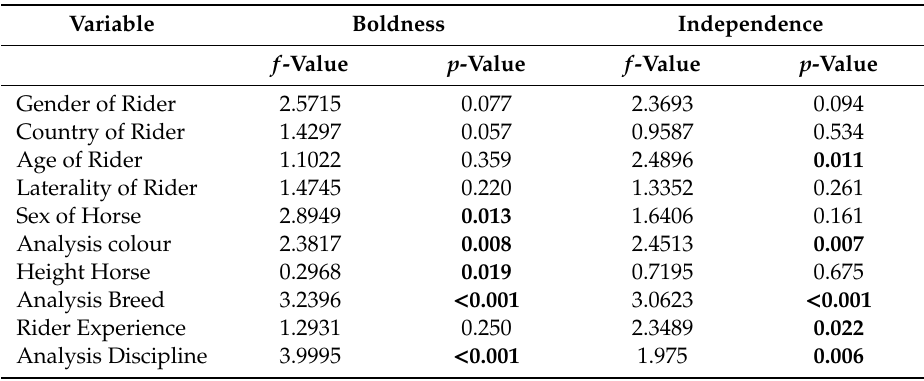
Table 3. Univariate analysis of other predictor variables (including potential confounders) for Boldness and Independence, assessed for potential inclusion by univariate analysis. Significant di ff erences appear in bold.